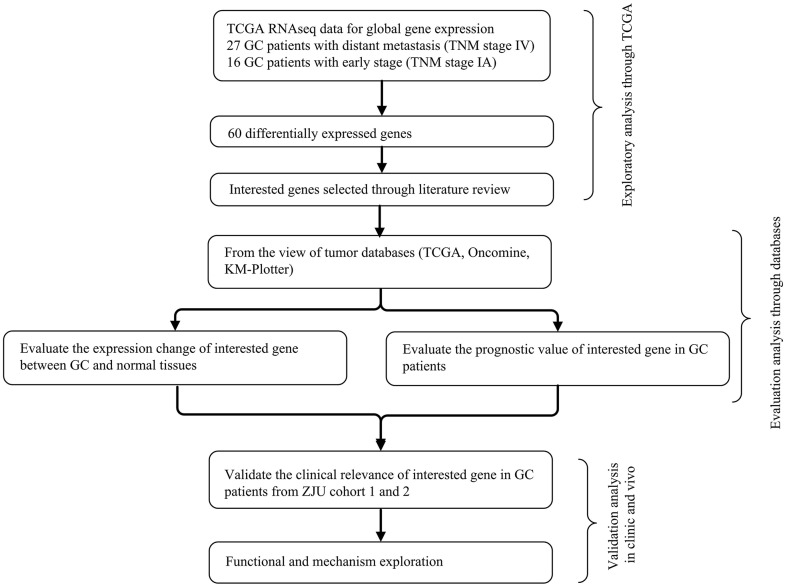
The integrative analytic strategy in this study. GC, Gastric cancer; KM–Plotter, Kaplan-Meier Plotter database; ZJU, Zhejiang University.